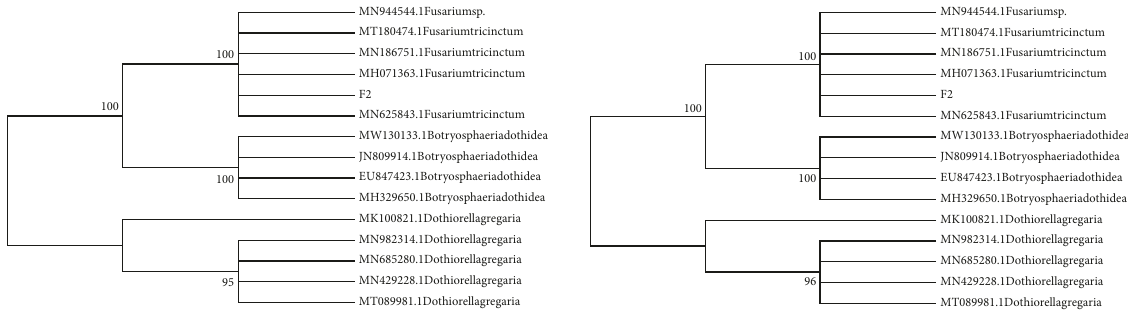
Figure 3: Phylogenetic trees of the ITS sequence of strain F2 constructed based on the N-J and M-L